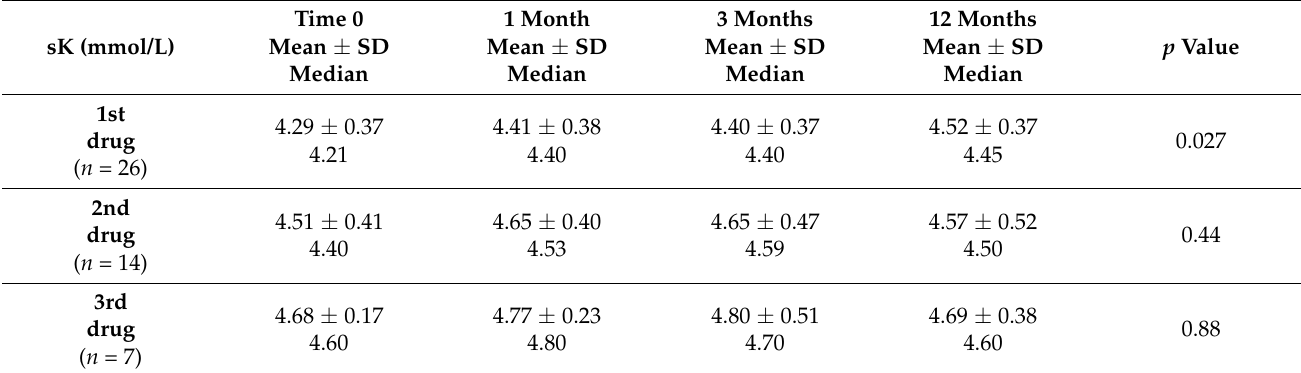
Table 4. Distribution of sK values at different time points from the introduction of the first, second, and third RAAS blocker. All p values are from Repeated Measures Anova